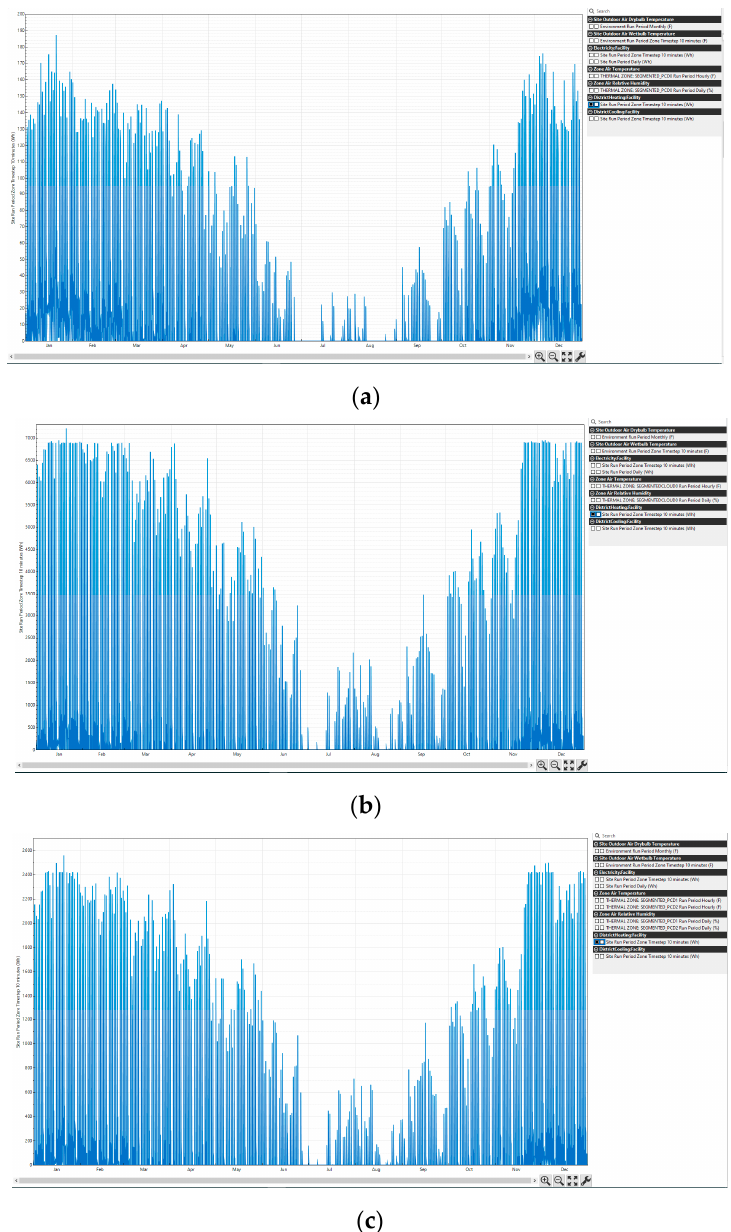
Figure 11. Energy consumption for heating systems for: ( a ) Scenario 1; ( b ) Scenario 2; ( c ) Scenario 3.